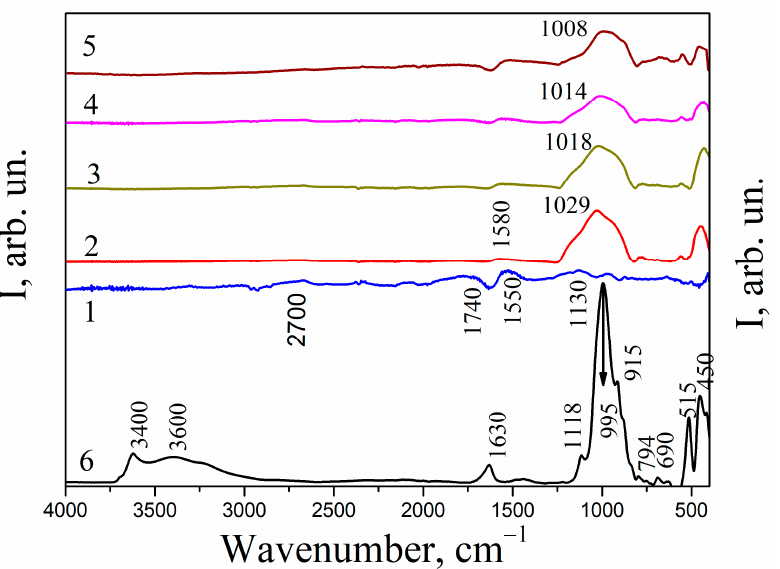
Figure 2. FT-IR spectra of carbonized tannin–bentonite materials: 1—TC (control), 2—TBC-3, 3—TBC-2, 4—TBC-1, 5—TBC-0.5, 6—bentonite.